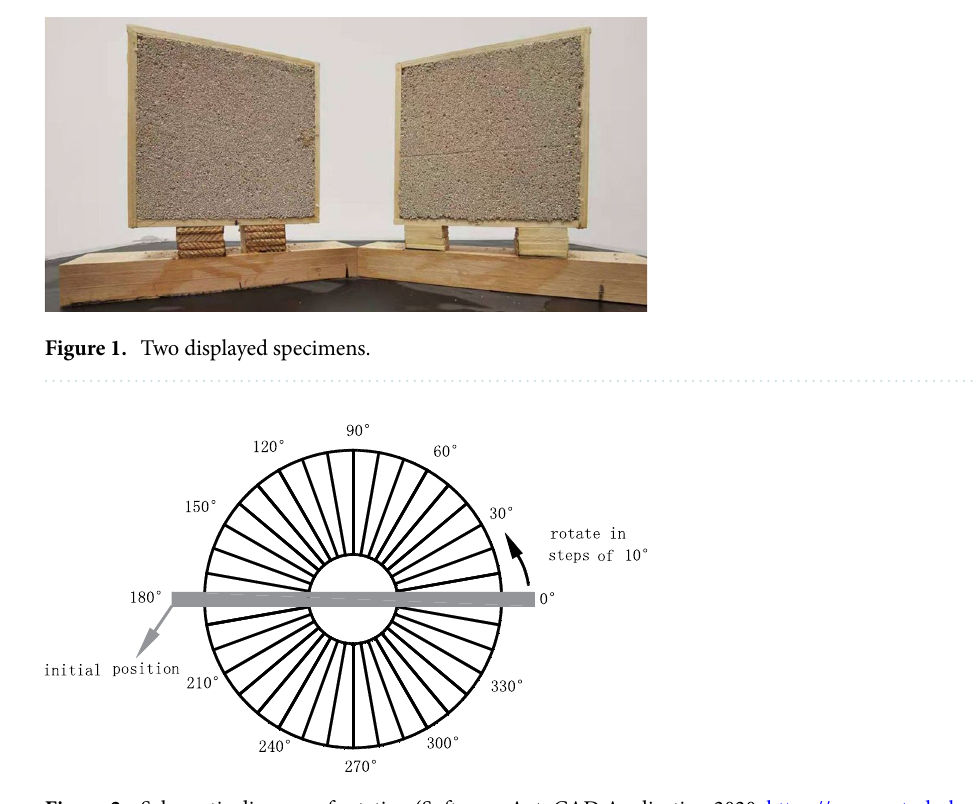
Figure 2. Schematic diagram of rotating (Software: AutoCAD Application 2020; https:// www. autod esk. com.